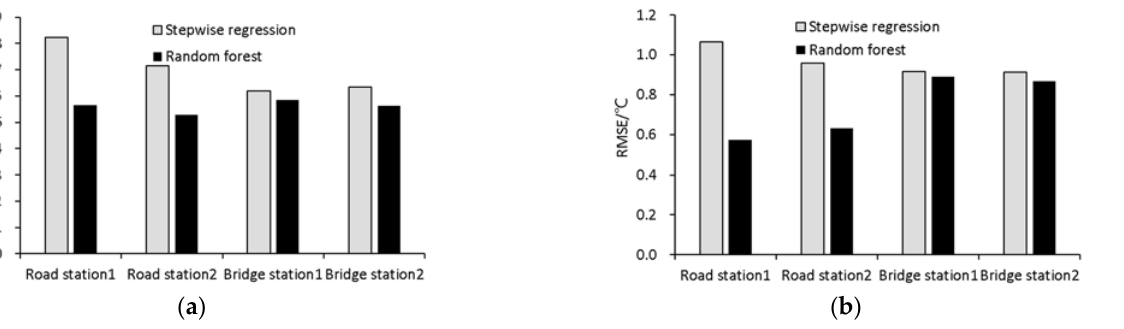
( d ) Figure 9. Scatter plot for observations and retrievals of road surface (bridge deck) temperature using the random forest model at road surface station 1 ( a ), road surface station 2 ( b ), bridge deck station 1 ( c ), and bridge deck station 2 ( d ). The training set was used to establish the model, and the test set was used to calculate MAE and RMSE (Figure 10). MAE of the two road surface stations retrieved by the ran ‐ dom forest model are 0.57 °C and 0.53 °C, and RMSE are 0.57 °C and 0.63 °C, respectively. MAE of the two bridge deck stations are 0.59 °C and 0.56 °C, and RMSE are 0.89 °C and 0.87 °C, respectively. The random forest algorithm is superior to the stepwise regression algorithm in both road surface and bridge deck temperature retrieving. Especially in the